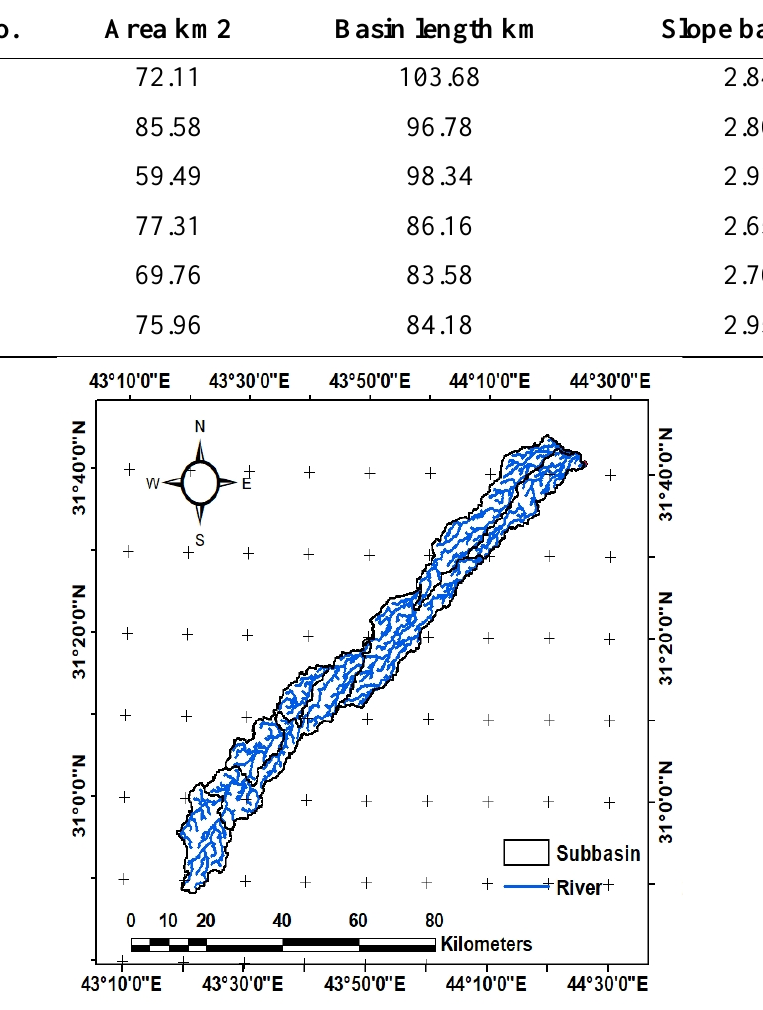
Fig. 6. The distributary's streams of the basin